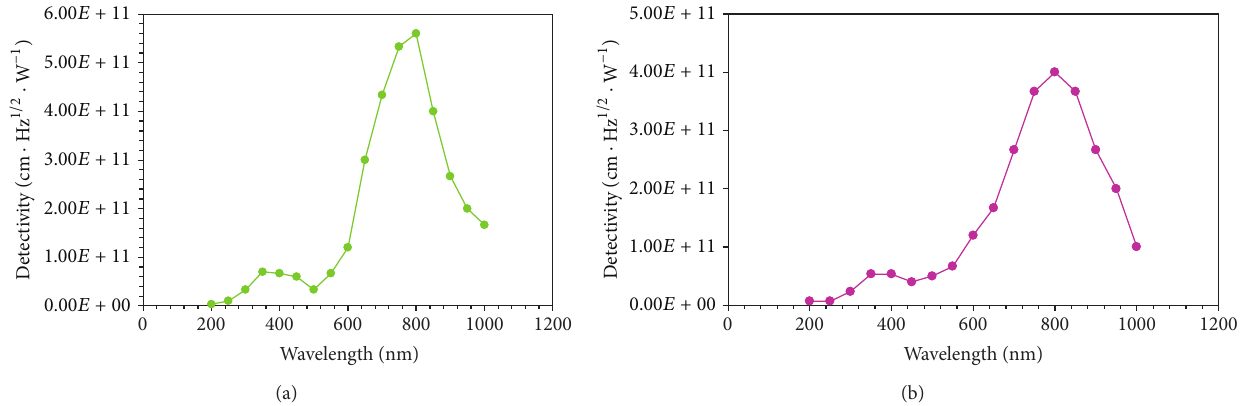
Figure 10: The Quantum efficiency as a function of the incident wavelength. (a) (n-SnO 2 /n-Si) device, (b) (n- SnO 2 /p-Si) MIS device.